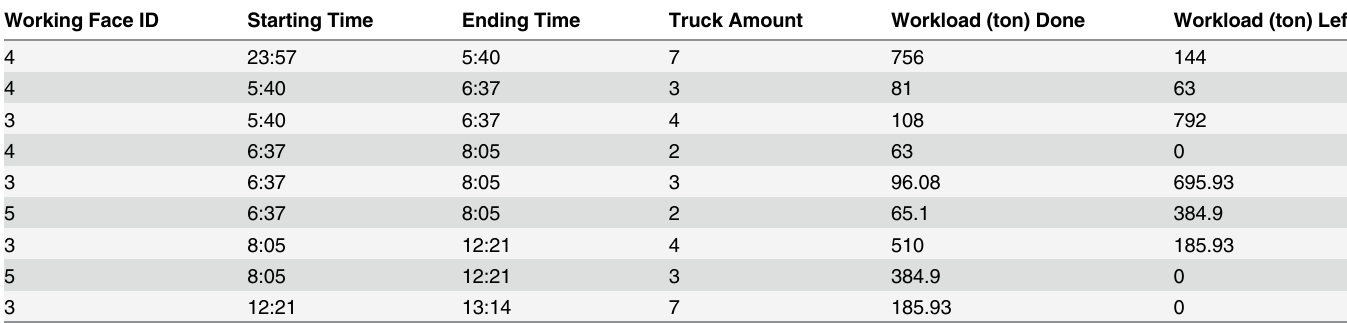
Table 3. Assignment of mucking machines at working faces.